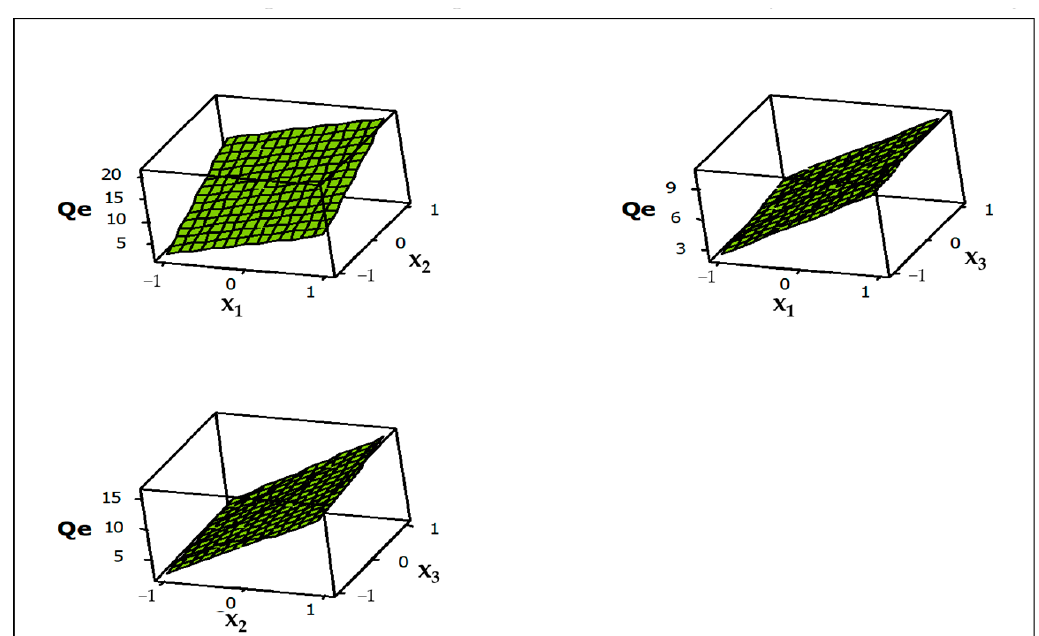
Figure 8. Response surface plots for desorption of MB from the clay adsorbent coating.